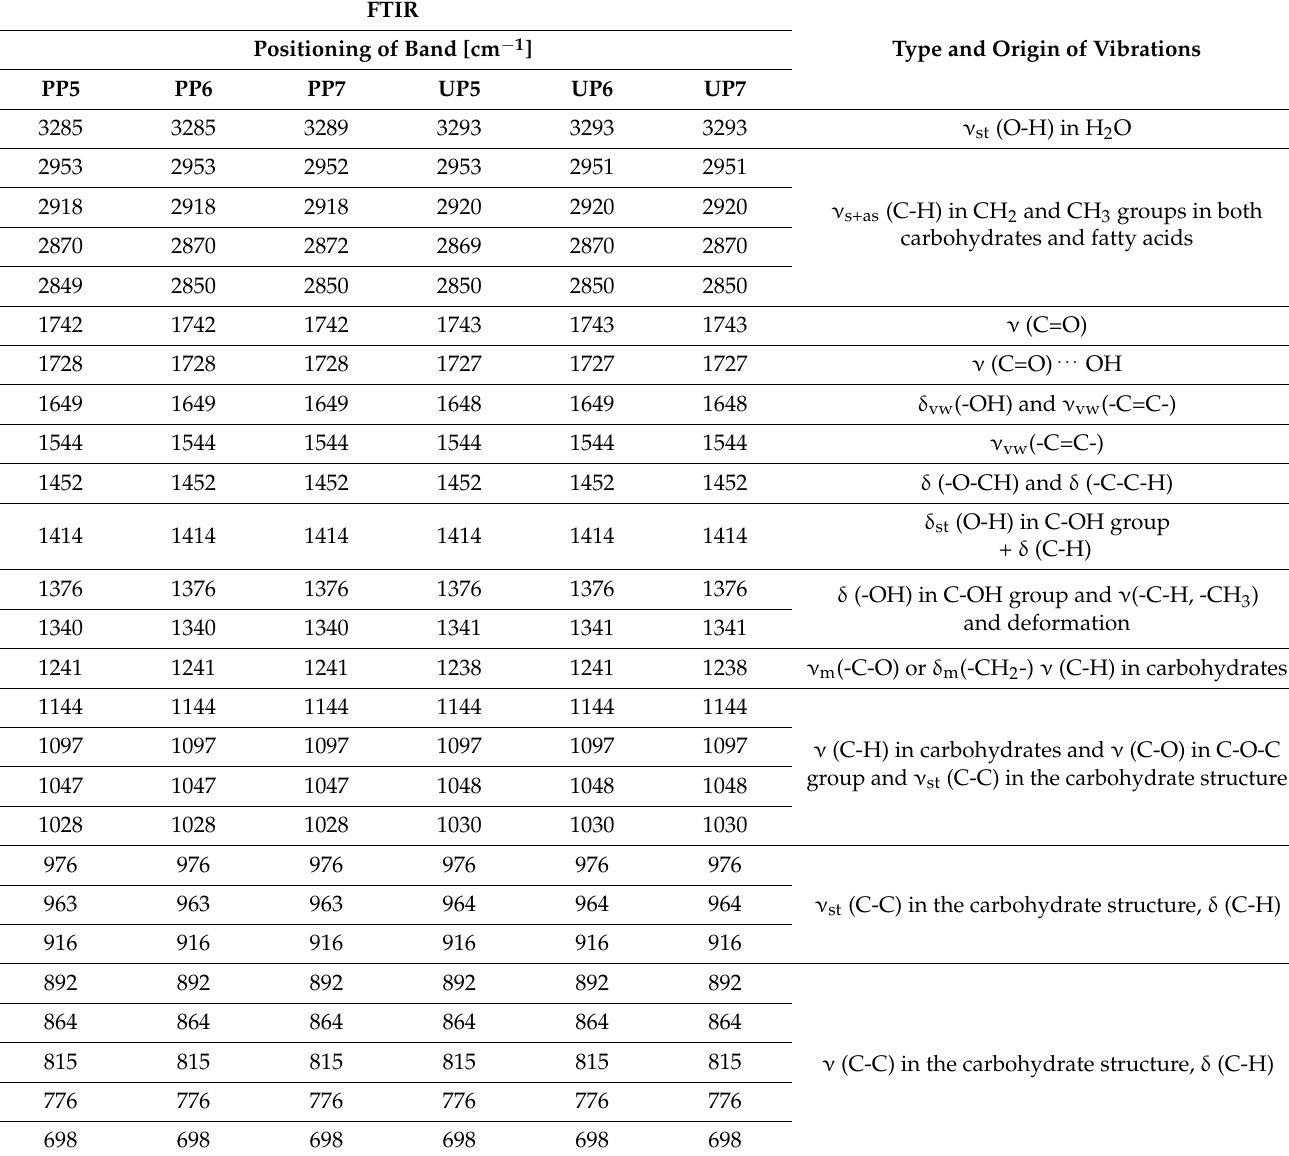
Table 4. The location of the maxima of absorption bands FTIR with arrangement of appropriate vibration for selected for sampling: PP5, PP6 and PP7 and UP5, UP6 and UP7 [40–47]. FTIR